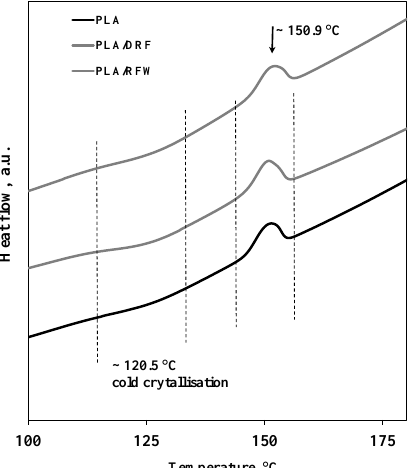
Figure 5. DSC trends of neat PLA and PLA containing 10%wt. of DRF and RFW. Table 2. Melt temperature, T °C, and fusion enthalpy, ∆H, on the second heating scan for neat PLA and PLA containing DRF and RFW.